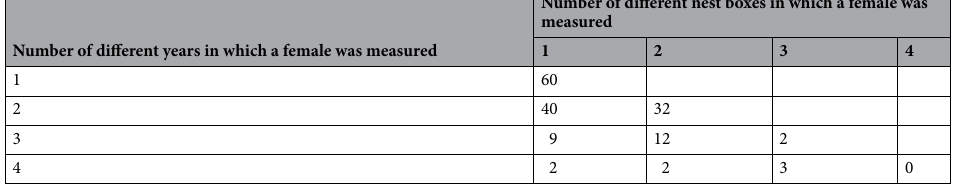
Table 1. Overview of the number of different nest boxes and years in which females were measured. For example, there were 12 individuals that were measured in 3 different years in 2 different nest boxes (i.e. they moved once) and 9 individuals that were measured in 3 different years in only 1 nest box (i.e. they did not move). Repeated measures within years are not included in this table.